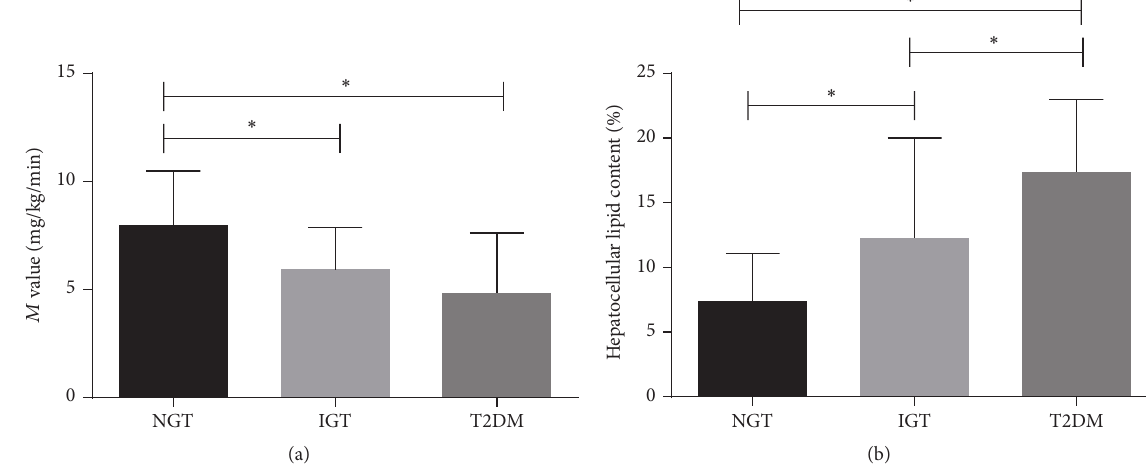
Figure 1: The (a) insulin sensitivity ( 𝑀 value) and (b) hepatocellular lipid content in different glucose tolerance status. ∗ refers to the 𝑃 value of comparison between groups which is less than